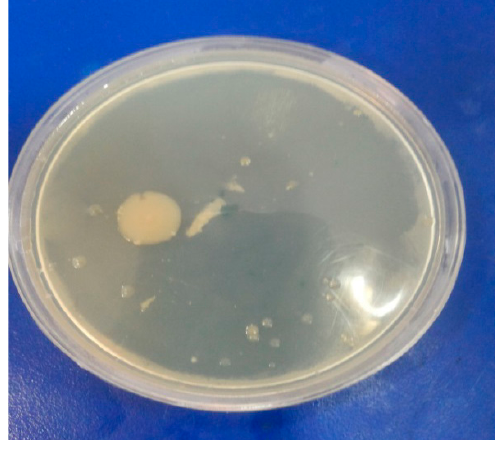
Figure 4. Helminthosporium oryzae